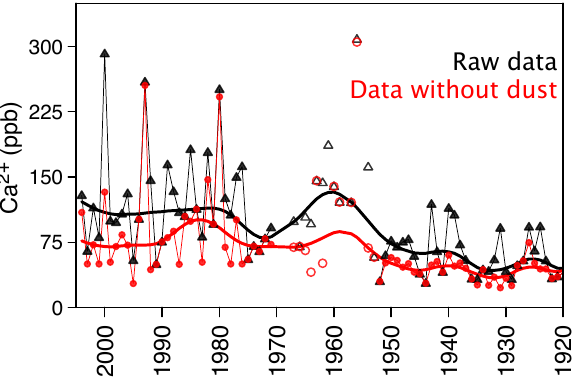
Fig. 4. Summer half-year means of calcium along the well-dated part of the CDK ice core (solid dots). The open points correspond to samples from the C11 ice core (see Sect. 2.1). The thick solid lines are robust spline smoothing (Bloomfield and Steiger, 1983). Black dots and lines refer to raw data, red ones to data after having discarded Saharan dust events (see Sect. 3.1).